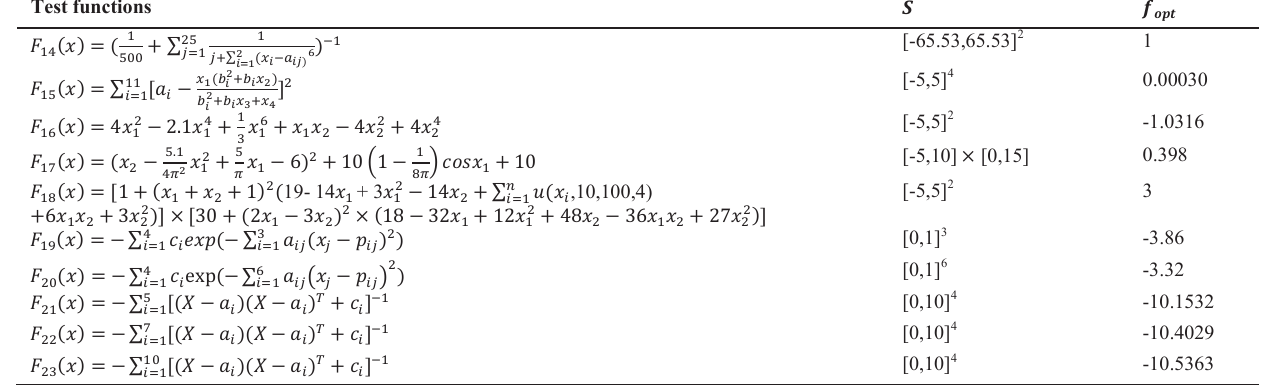
Table 3. Multimodal test functions with fix